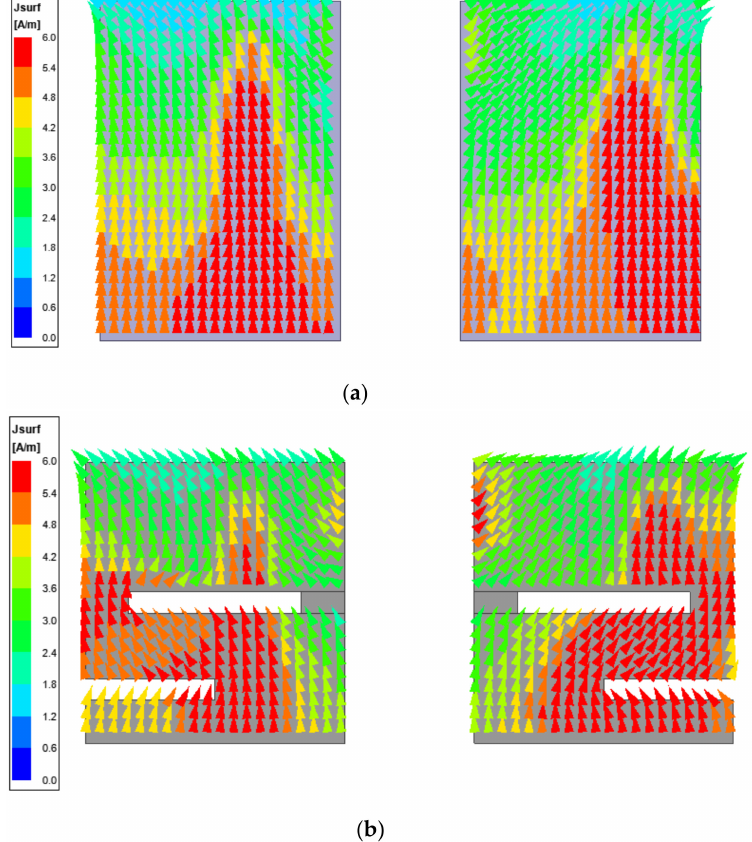
Figure 4. Current distributions on the metal wall ( a ) without slots and ( b ) with